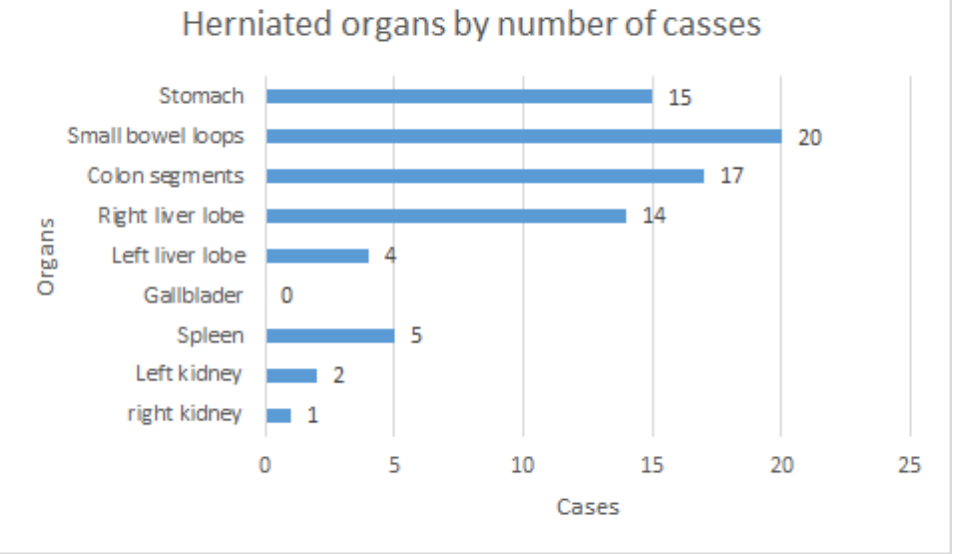
Figure 4. Bar diagram showing the number of cases a specific organ has been identified in the thoracic cavity. Table 2. Statistical analysis between the LHRP and various